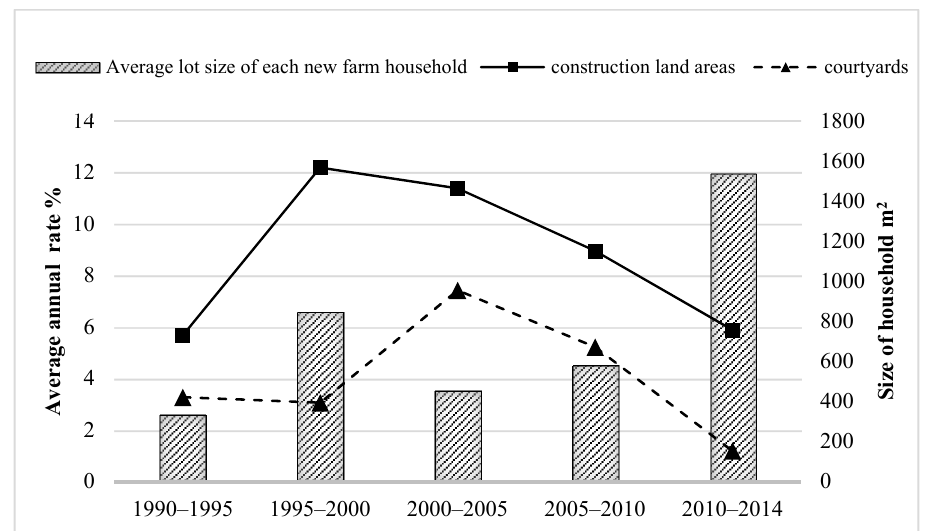
Figure 3. Average annual rate of construction land (CL) and courtyards (line chart), and average lot size of new households (bar chart) from 1990 to 2014.